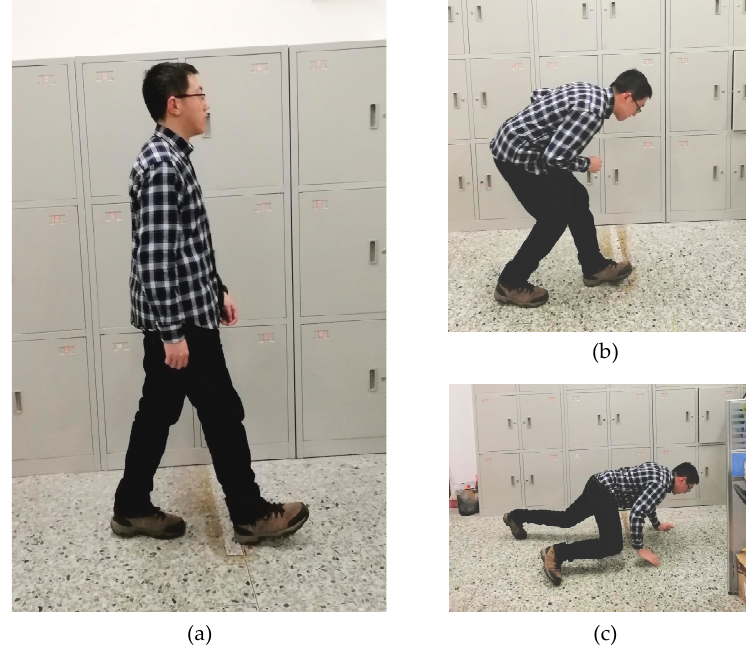
Figure 1. Different moving patterns in intrusion scenarios. ( a ) Regular walking; ( b ) walking while bending down; and ( c ) creeping.